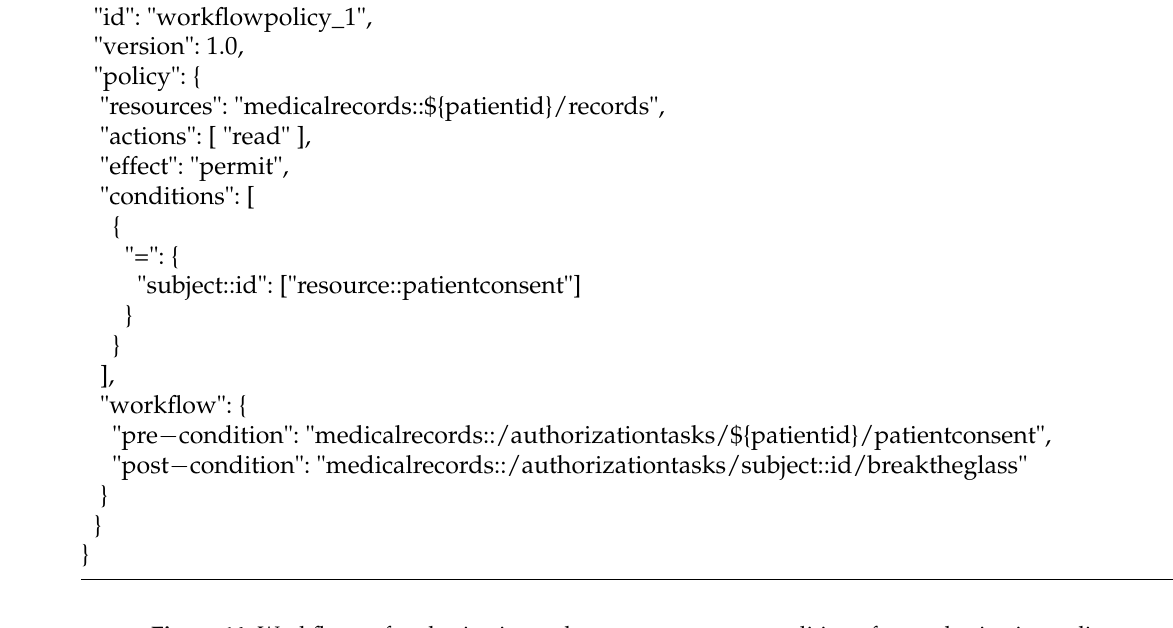
Figure 14. Workflows of authorization tasks as a pre- or post-condition of an authorization